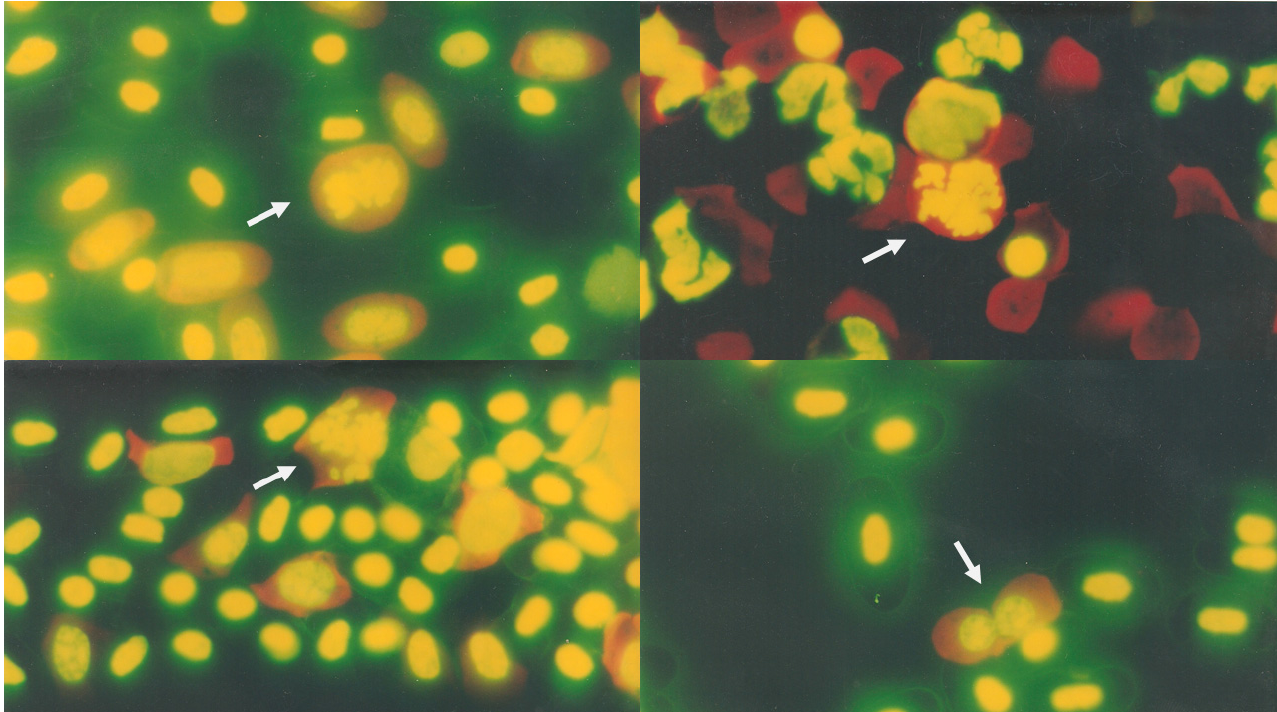
Figure 3. Crocodile blood smears: erythrocytes were observed in mitosis.